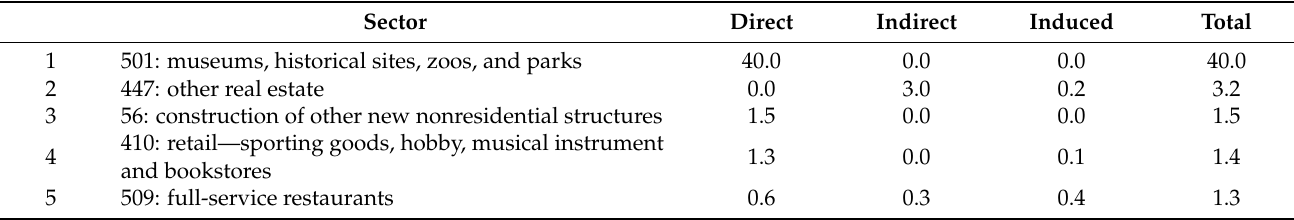
Table A18. Top Five Affected Sectors by